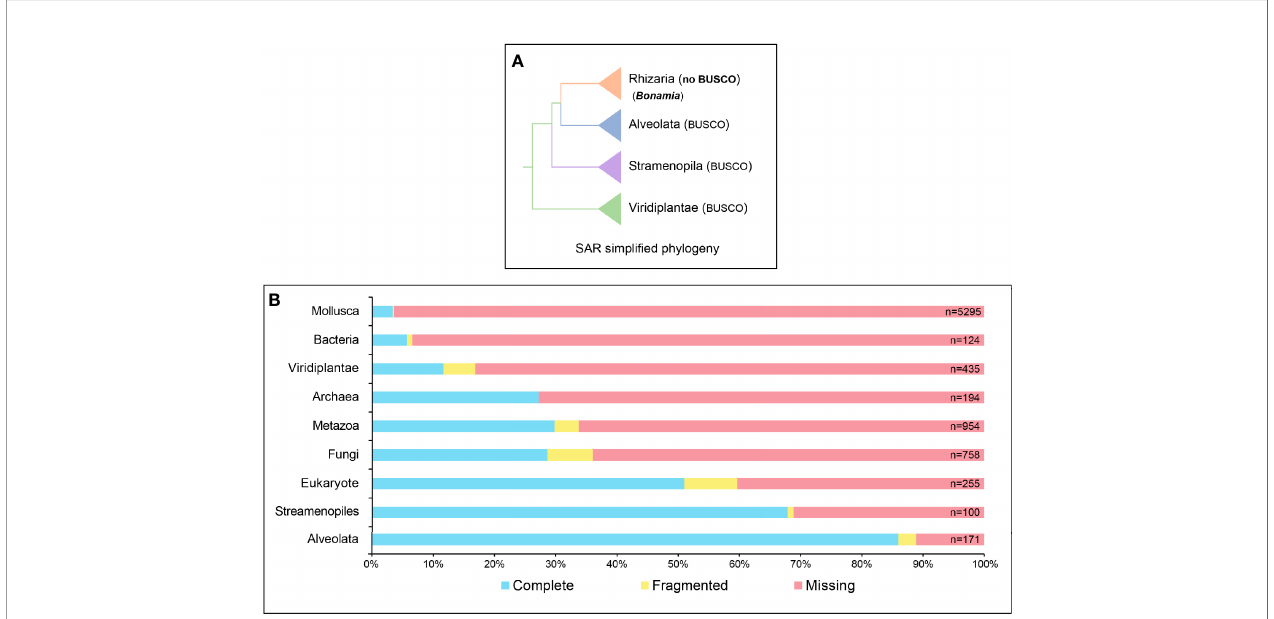
FIGURE 4 | BUSCO transcriptome evaluation. (A) Simpli fi ed Stramenopila, Alveolata, and Rhizaria (SAR) phylogeny adapted from Sierra et al. (2016). The Rhizaria clade does not have a proper BUSCO database due to the lack of genomic data in this clade, whereas the closely related clades Alveolata and Stramenopila are represented by proper BUSCO databases. (B) BUSCO evaluation of the B. ostreae transcriptome. This evaluation has been performed by interrogating a large panel of different database clades related or not to B. ostreae and its host, O. edulis